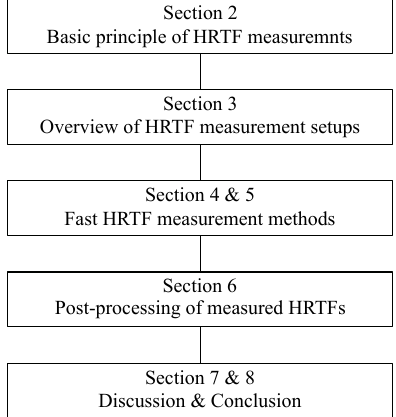
Figure 1. An overall structure of the rest of this review